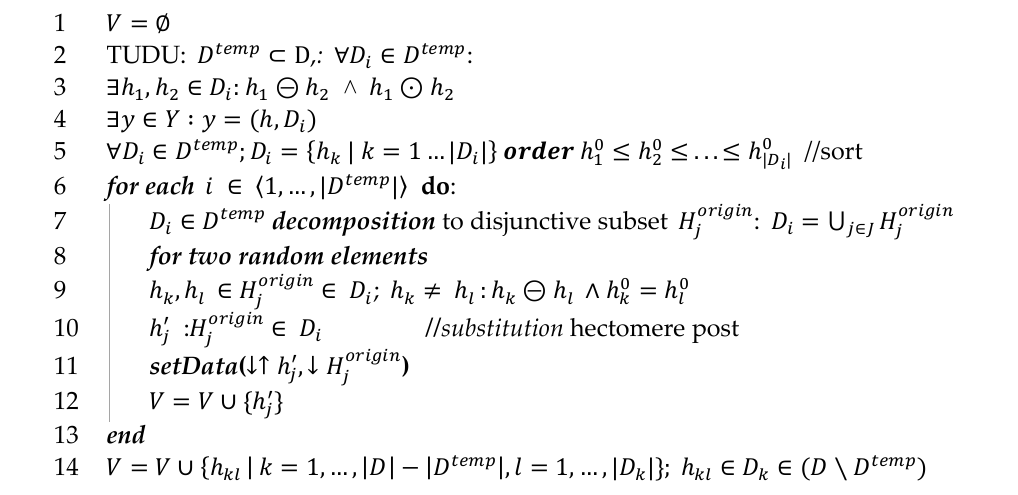
Algorithm 1. Formation of a vertex set within individual TUDUs. Algorithm 1: Formation of a vertex set within individual TUDUs.